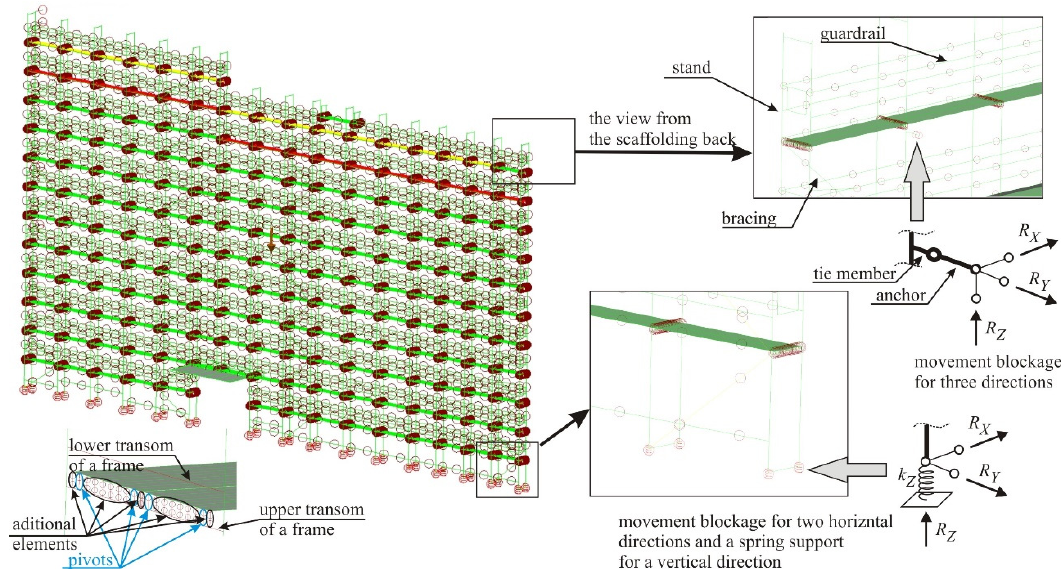
ff olding, configuration